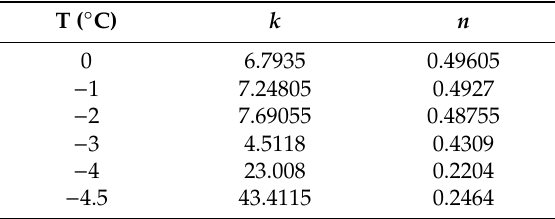
Table 1. Values of k and n for the ice cream mixture at di ff erent temperatures.